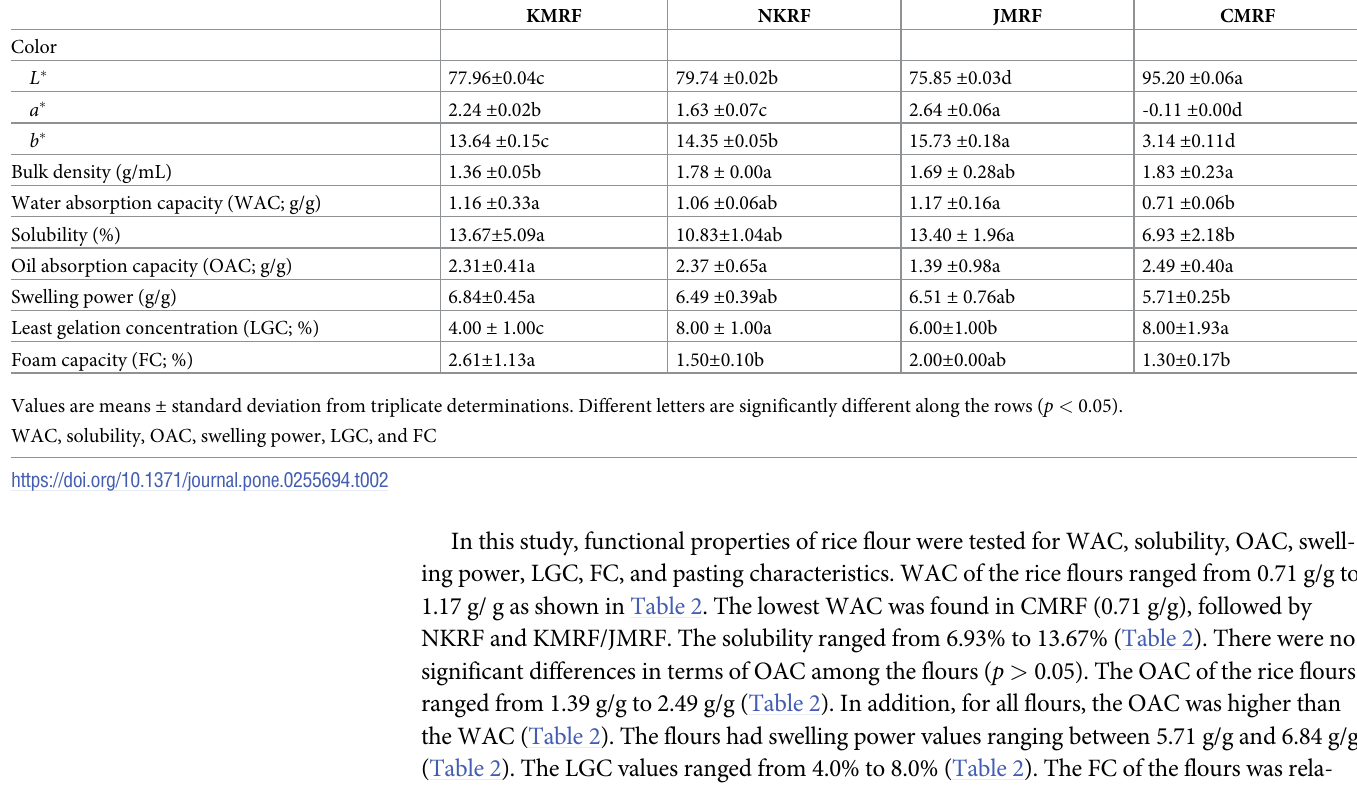
Table 2. Physical and functional properties of Thai indigenous brown rice flour, namely brown Khai Mod Rin rice flour (KMRF) and brown Noui Khuea rice flour (NKRF), in comparison with brown Jasmine rice flour (JMRF) and commercial rice flour (CMRF). Parameters